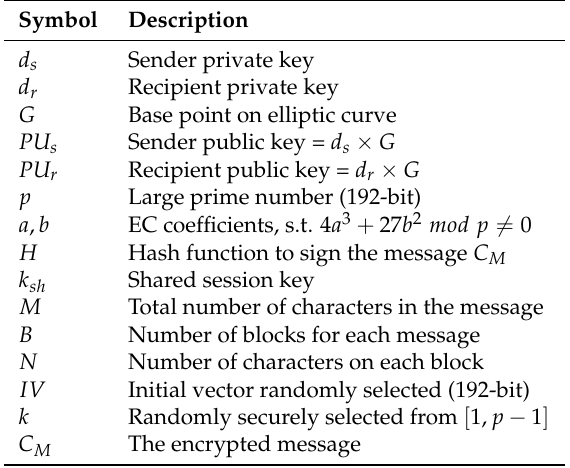
Table 1. List of symbols used to generate scheme parameters.